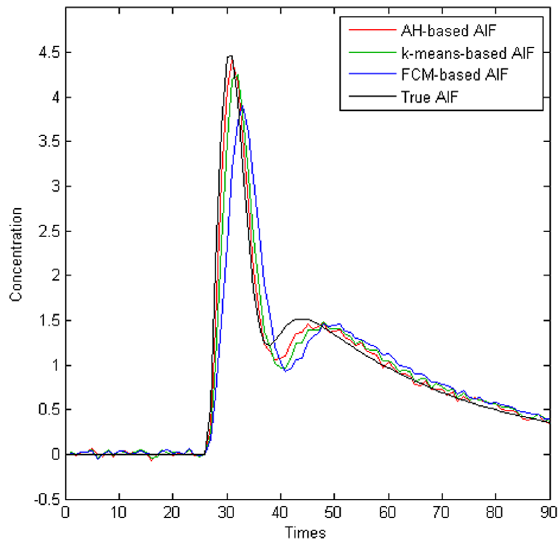
Figure 2. Comparison of AIFs obtained using different clustering algorithms and the true